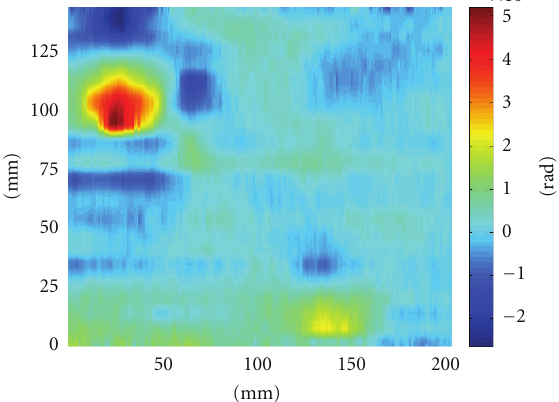
Figure 9: Color map reconstruction of slope di ff erences Δ ϕ (rad) considering horizontal